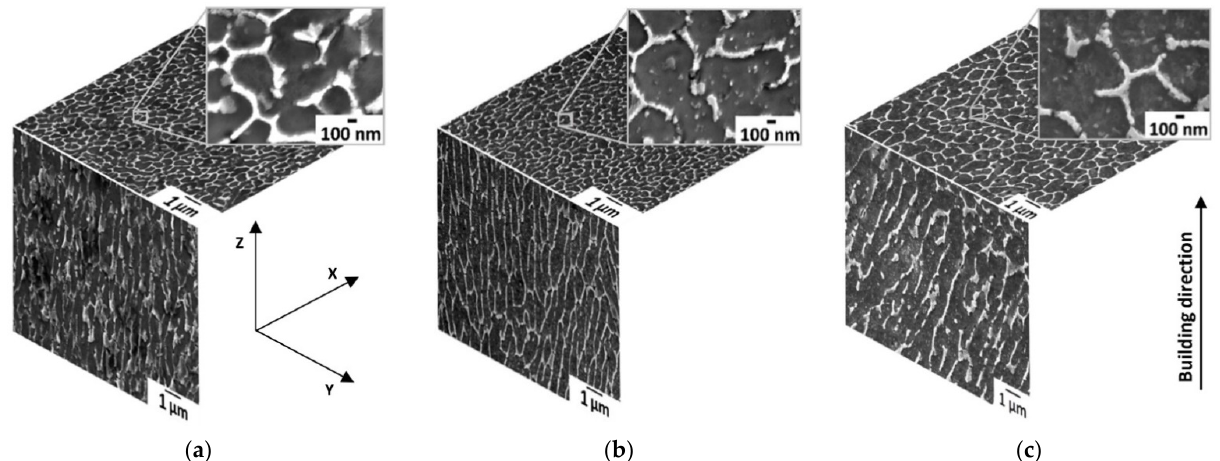
Figure 5. High-magnification SEM images (10,000× and 50,000×) of the typical microstructure at 35 °C F ( a ), T5 ( b ) and 200 °C F ( c ) build conditions. The Al matrix is the dark phase and the lighter phase surrounding the Al matrix is Si particles. In ( b ) and ( c ), discrete Si precipitations were observed from thermal heat treatment.